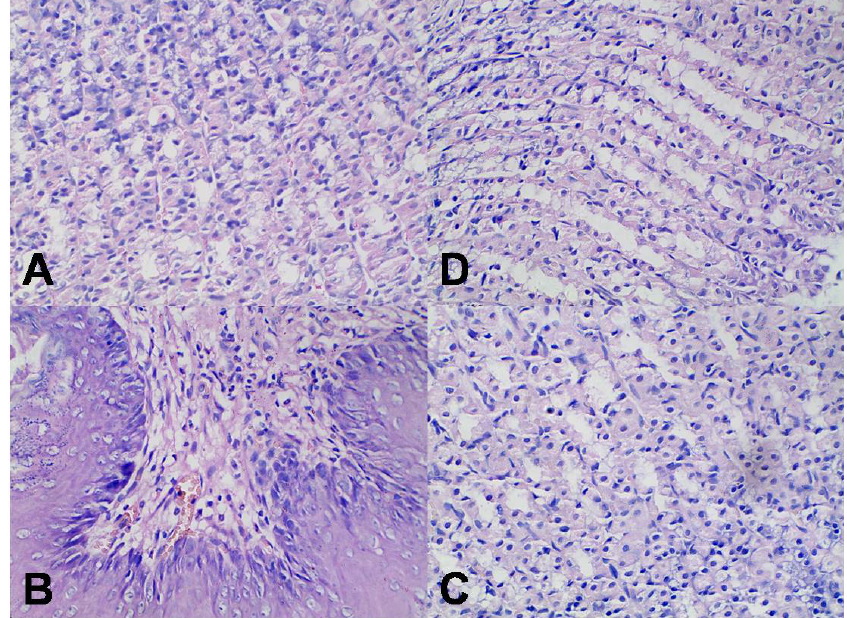
Figure 7. Histological examination of gastric tissue of rats (hematoxylin and eosin staining, 400 ×). Results were derived from oral administration of TP ( B ) and TP-SLN ( C ), intraperitoneal injection of TP ( D ) at the dose of 1.0 mg/kg. Control group ( A ): oral administration of 0.5% sodium carboxymethyl cellulose